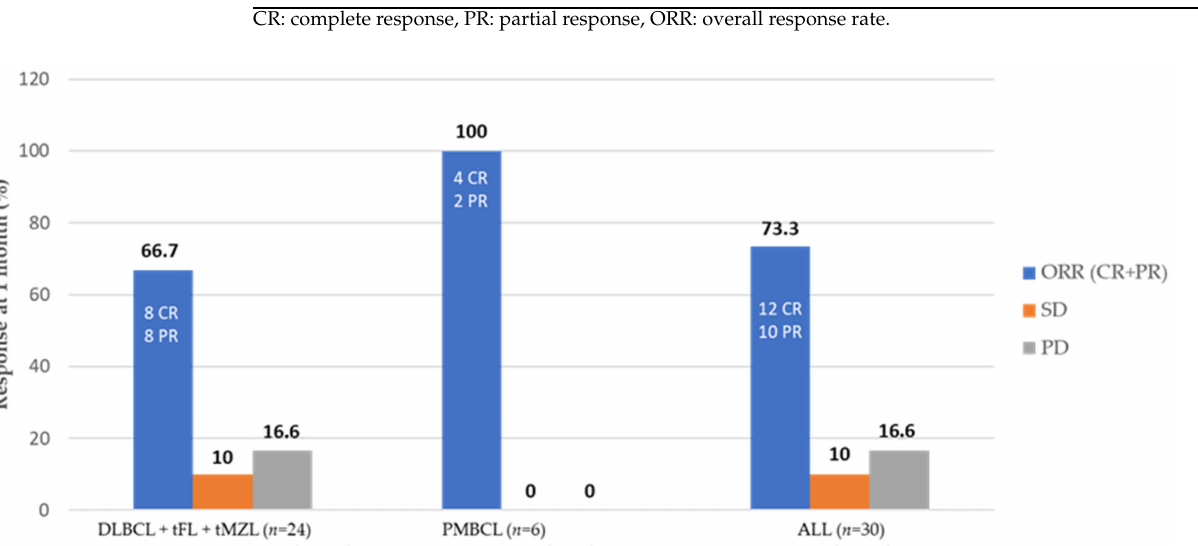
Figure 1. Objective response rates at one month after CAR T-cell infusion. CR: complete response, PR: partial response, ORR: overall response rate, SD: stable disease, PD: progression disease. DLBCL: diffuse large B cell lymphoma, PMBCL: primary mediastinal B cell lymphoma, tFL: transformed follicular lymphoma, tMZL: transformed marginal zone